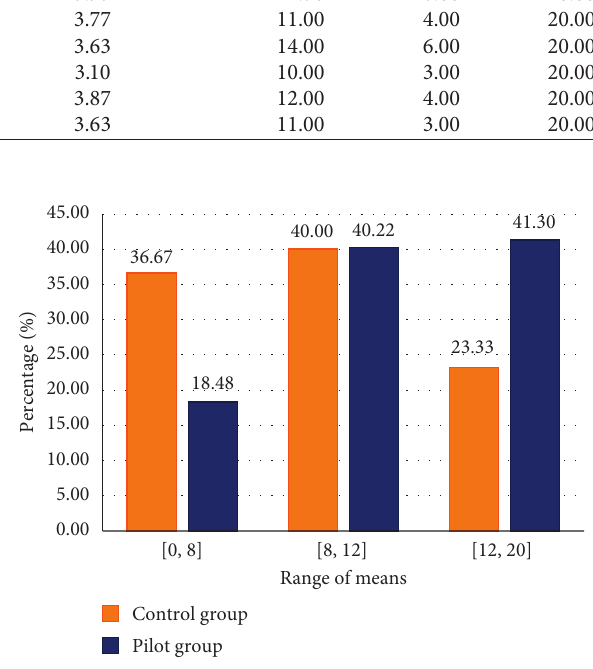
Figure 3: Distribution of the means of the posttest results in the pilot group and the control Table 8: Mann–Whitney test for the independent samples posttest according to the method used.